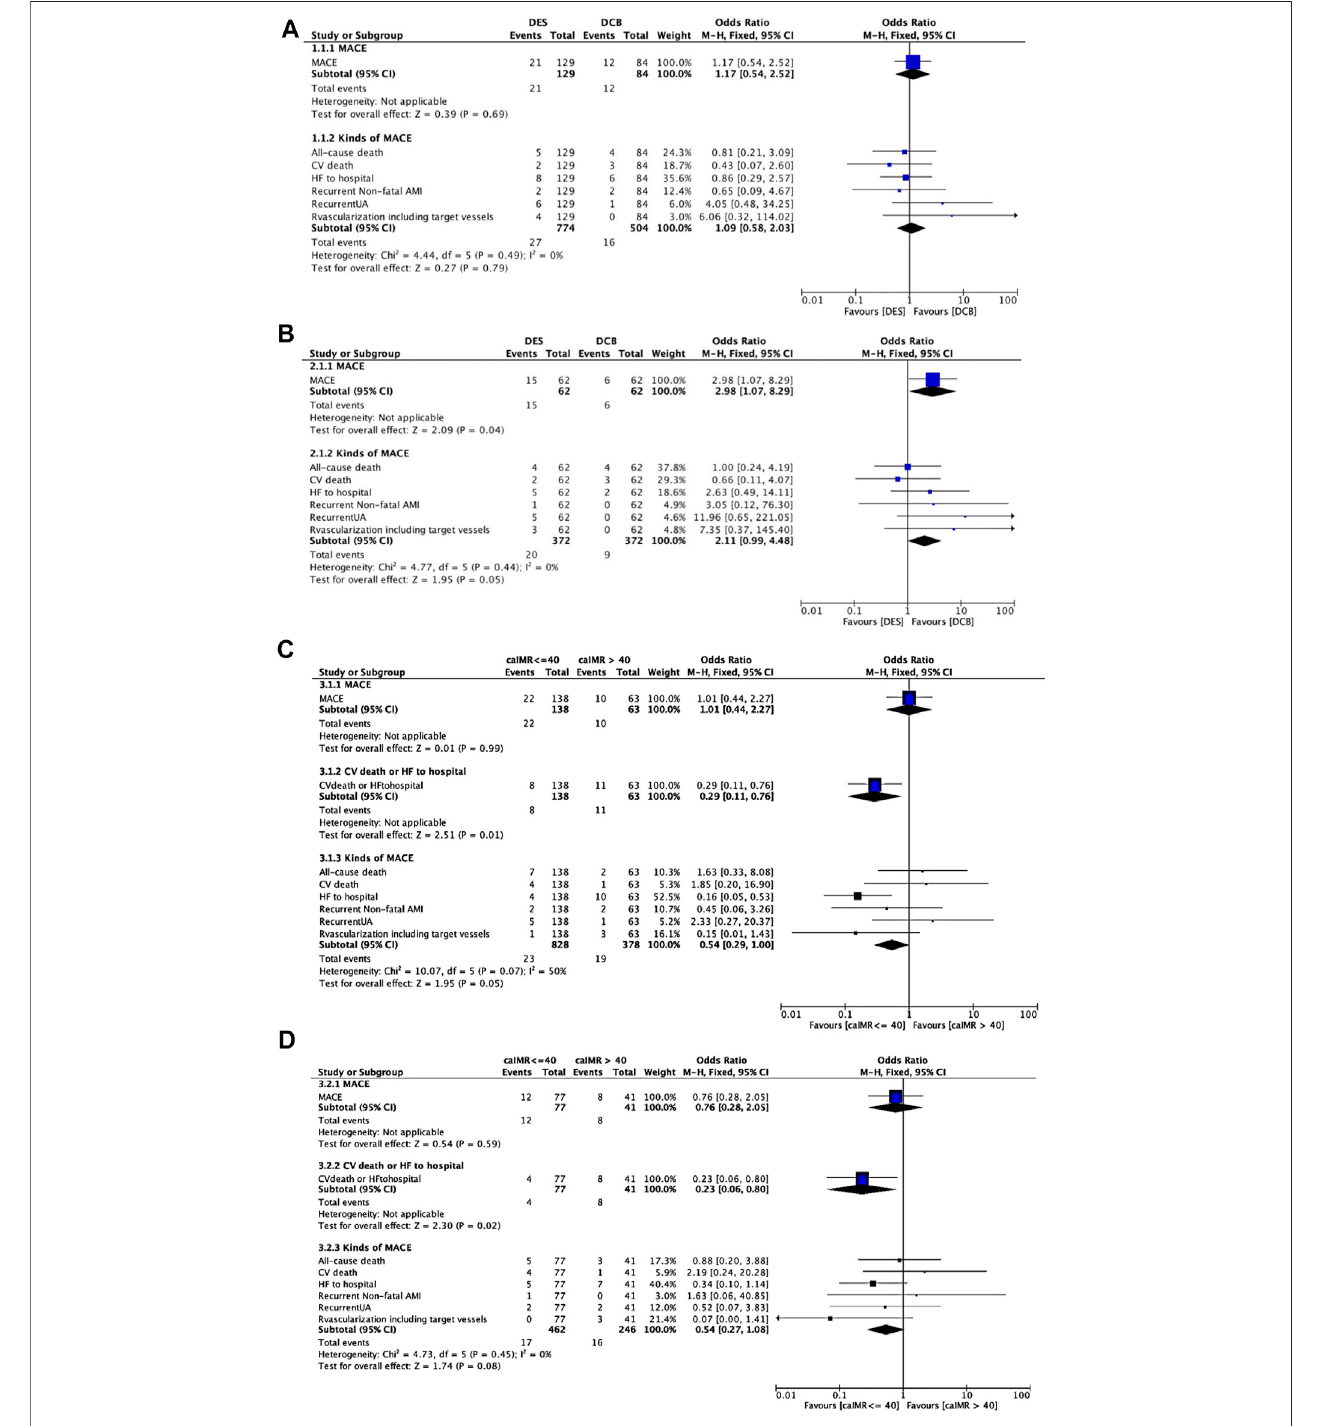
FIGURE 3 | MACEs comparing DES and DCB groups. (A). MACEs comparing DES and DCB groups before propensity score matching. (B) . MACEs comparing DES and DCB groups after propensity score matching. (C) . MACEs comparingcaIMR ≤ 40U and caIMR > 40U in group DES. (D) . MACEs comparingcaIMR ≤ 40U and caIMR > 40U in group DCB. Abbreviations: DES, drug-eluting stents; DCB, drug-coated balloons; caIMR, coronary-angiography-derived index of microcirculatory resistance; MACE, major adverse cardiovascular events; CV, cardiovascular; HF, heart failure; AMI, acute myocardial infarction; UA, unstable angina; CI, con fi dence